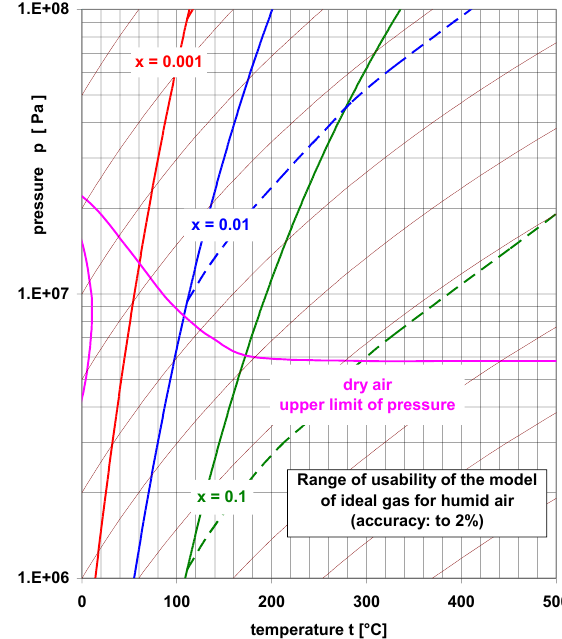
Fig. 7b. Area of usability of the ideal gas model for the calculation of properties of components of moist air at the required accuracy of the calculation to % 2 for specific moisture x of